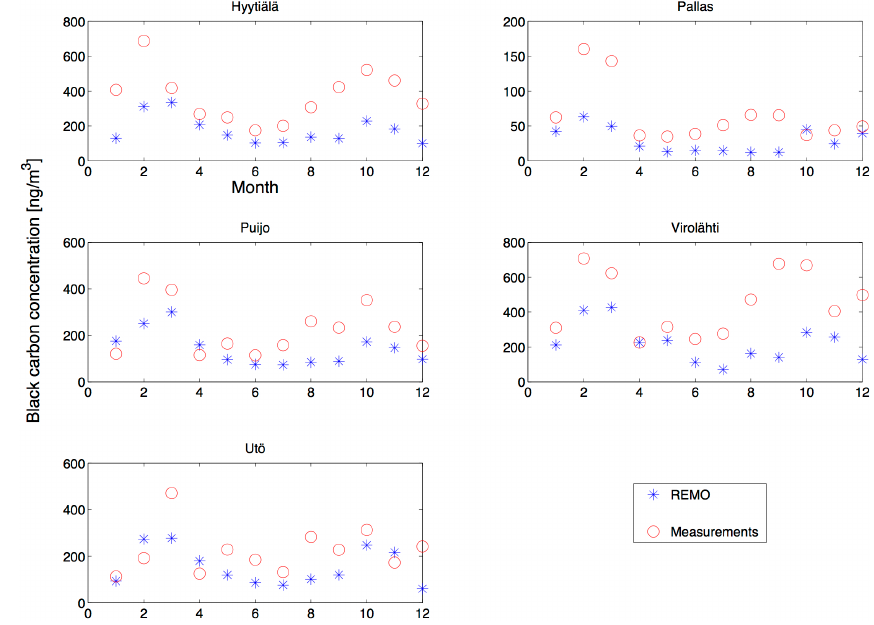
Fig. 3. Monthly average of black carbon concentrations (red circles represent the measurements and the blue stars the model result for the year 2005).